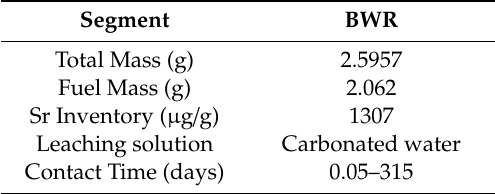
Table 3. UO 2 spent nuclear fuel sample